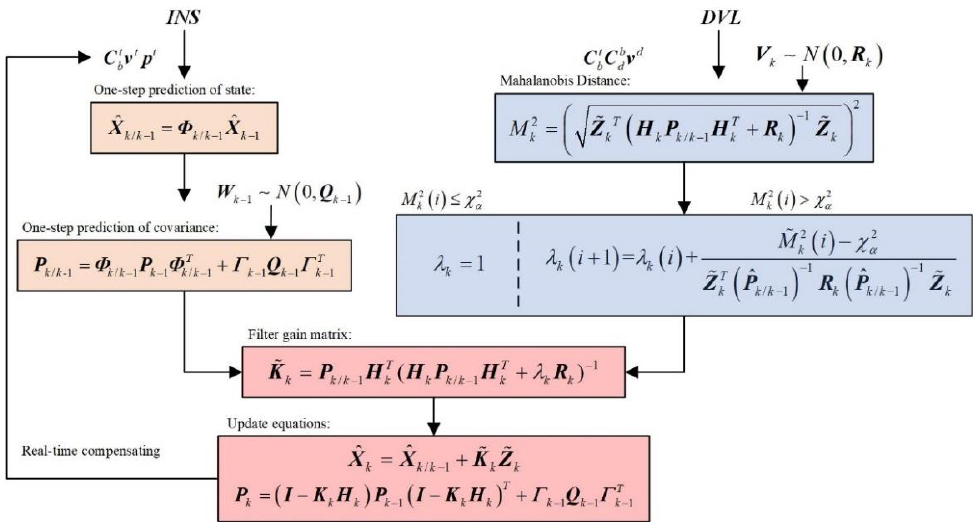
Figure 3. The robust Kalman filter flow diagram.